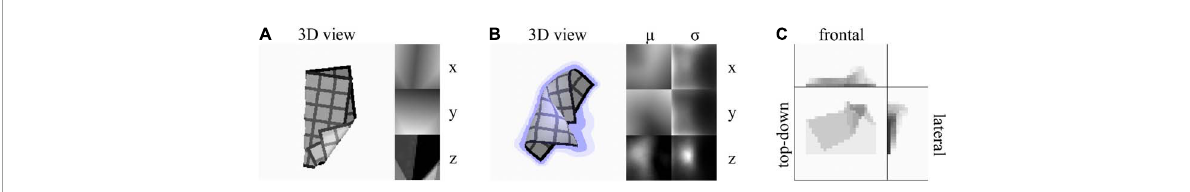
FIGURE2 (A) A deterministic mesh representation (DMR). Left: Top-down 3D rendering of the mesh. Right: x, y, and z coordinates mapped as colour gradients in uv-space. Grey values for z-coordinates boosted for visibility. The grid texture on the 3D rendering is added for visualisation purpose only. The texture is not present in cloth observations and does not correspond to the mesh resolution. (B) A probabilistic mesh representation (PMR). Left: Top-down 3D rendering of the µ -component of the mesh. Lilac shading around the cloth indicates the σ x and σ y components, and lilac cast on the cloth indicates the σ z component. Right: µ x , µ y , µ z , σ x , σ y , σ z components mapped as colour gradients in uv-space. Grey values for µ z and σ z boosted for visibility. (C) A voxel representation. Colour indicates mean voxel value over each voxel column parallel to the viewing angle.